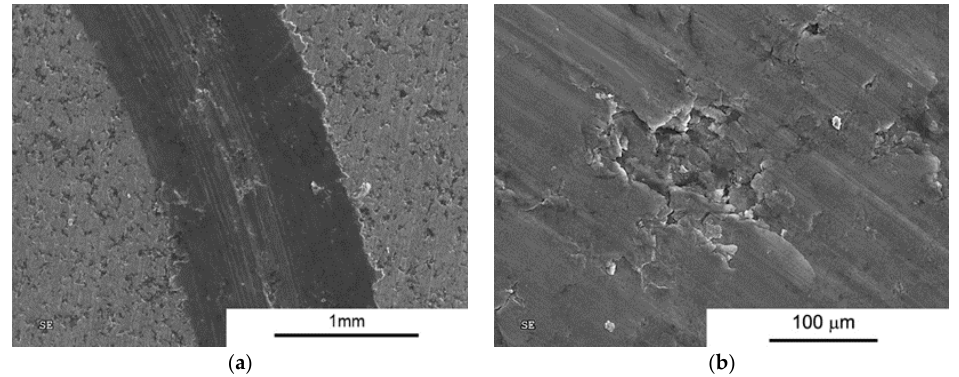
Figure 17. Worn Surface morphology for AA 6061 + 10 vol % MLG load 10N SPS. ( a ) Wear trace image; and ( b ) close-up view.